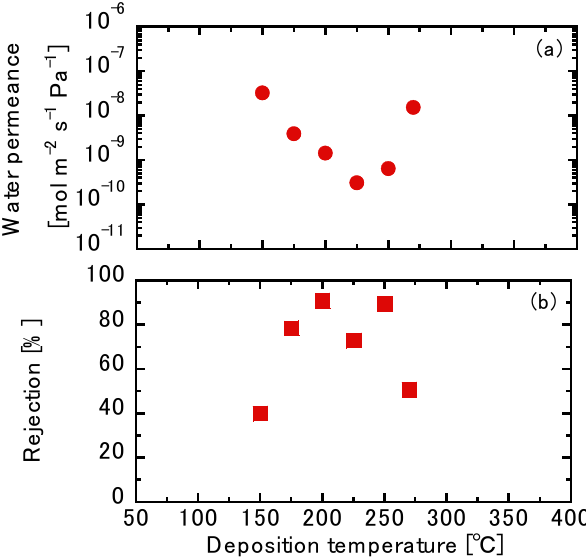
Figure 6. ( a ) The water permeance and ( b ) the NaCl rejection of TFPrTMOS-derived membranes.